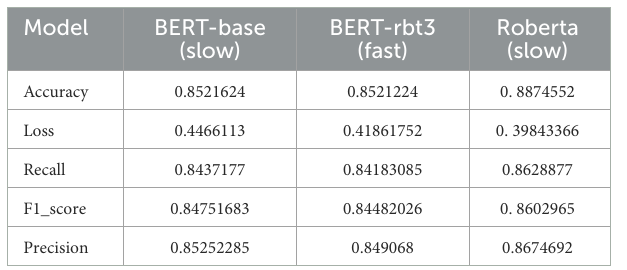
TABLE 2 Comparison of the performance of different pretraining models.